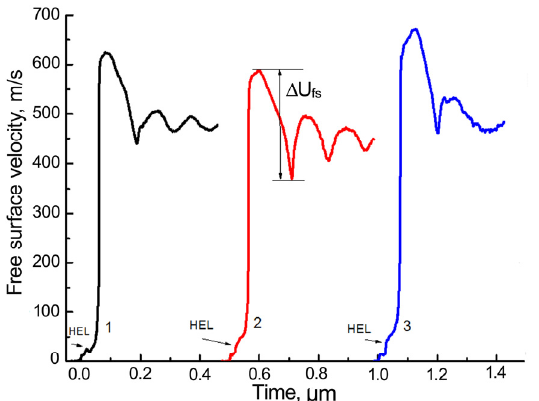
Figure 10. The hardness of aluminum matrix composites with different grain sizes.